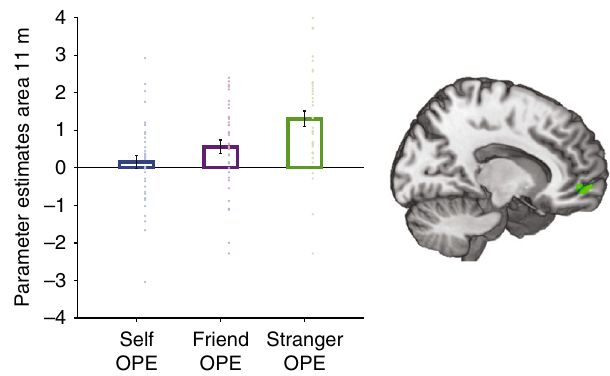
Fig. 6 Distinct coding of ownership prediction errors in area 11 m. Dorsal parts of area 11 m ( x = 10, y = 50, z = − 6; Z = 3.99, k = 83, p < .04 FWE- SVC) signalled prediction errors for stranger more than self but in fact tracked prediction errors for both friend ( p = .004) and stranger ( p < .001) and not self ( p > .05). Activation overlaid on an anatomical scan of the medial surface. Error bars indicate standard error of the mean. N